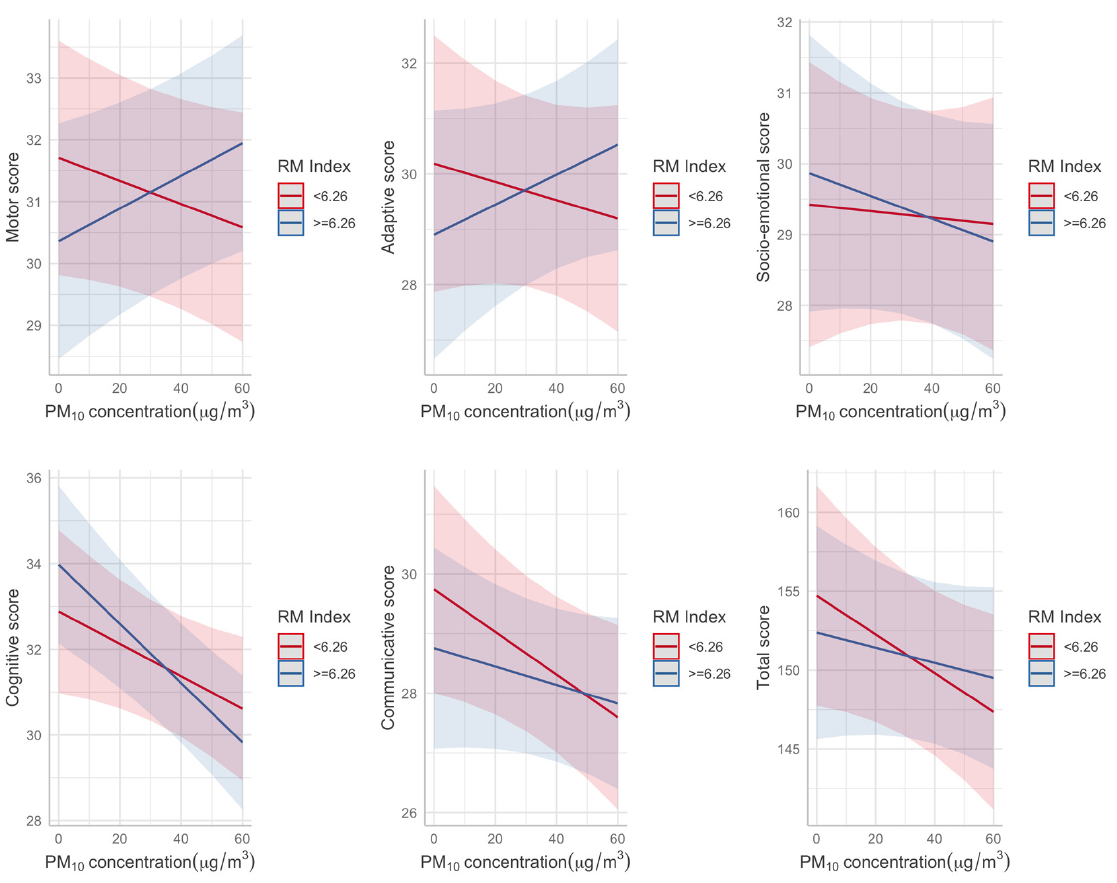
Figure 3. Predicted developmental scores by average prenatal PM 10 concentration for different categories of Residential Mobility (RM) index.